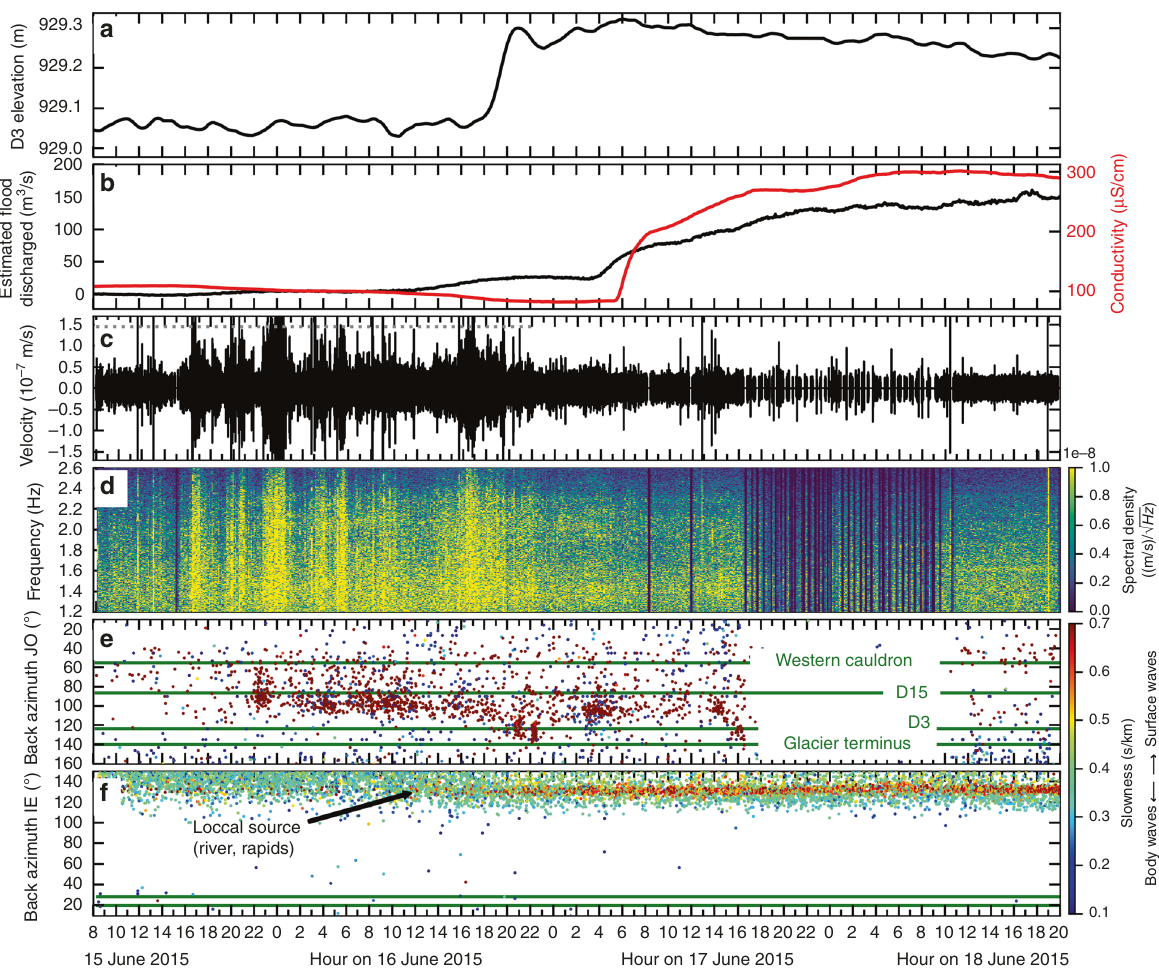
Fig. 4 Tracking a small fl ood from the western Skaftá cauldron on 15 – 19 June 2015. All sub fi gures as in Fig. 2 with the following differences: a Elevation of GPS instrument at D3. b , d similar to Fig. 2b. c Note that seismic recordings at JO array contain small gaps starting 17 June due to data transmission problems. Time windows with a lot of gaps were mostly discarded from the array processing. For better readability only data gaps of several hours are hatched. e The mean uncertainty is 5.3° (standard deviation 2.8°) in back azimuth and 0.05s/km (standard deviation 0.02s/km) in slowness. f The mean uncertainty is 4.1° (standard deviation 2.4°) in back anazimuthd 0.04s/km (standard deviation 0.03s/km) in slowness. Green lines mark the direction towards the western cauldron and D3 (top and bottom,